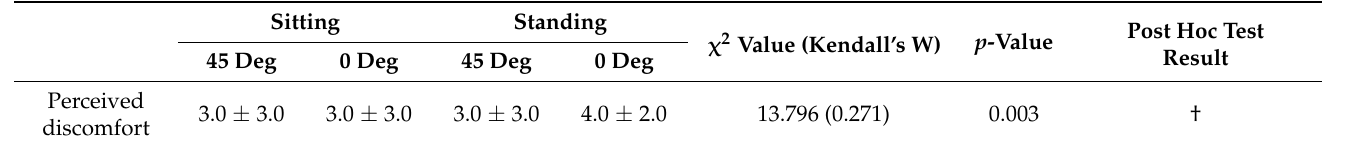
Table 1. Task performance and subjective physical burden during the task. Sitting Standing